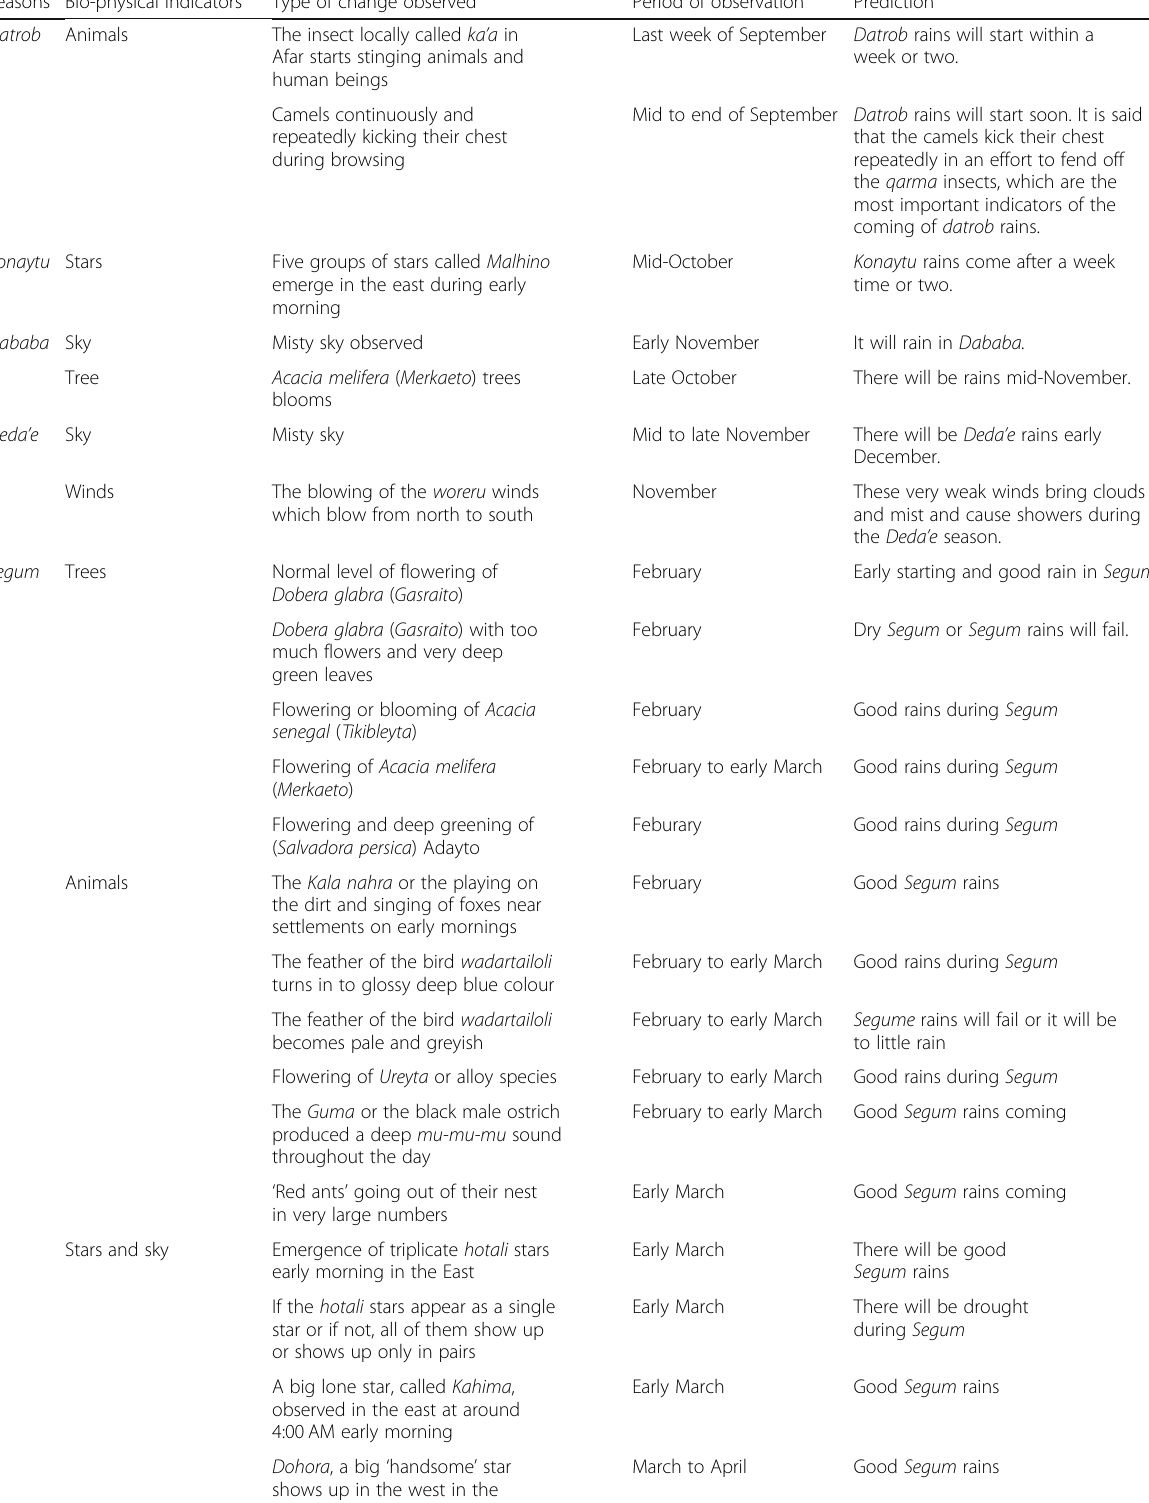
Table 3 Season-specific bio-physical indicators of indigenous weather prediction by Afar pastoralists Seasons Bio-physical indicators Type of change observed Period of observation Prediction Datrob Animals The insect locally called ka ’ a in Last week of September Datrob rains will start within a Afar starts stinging animals and week or two. human beings Camels continuously and Mid to end of September Datrob rains will start soon. It is said repeatedly kicking their chest that the camels kick their chest repeatedly in an effort to fend off during browsing the qarma insects, which are the most important indicators of the coming of datrob rains. Konaytu Stars Konaytu rains come after a week time or